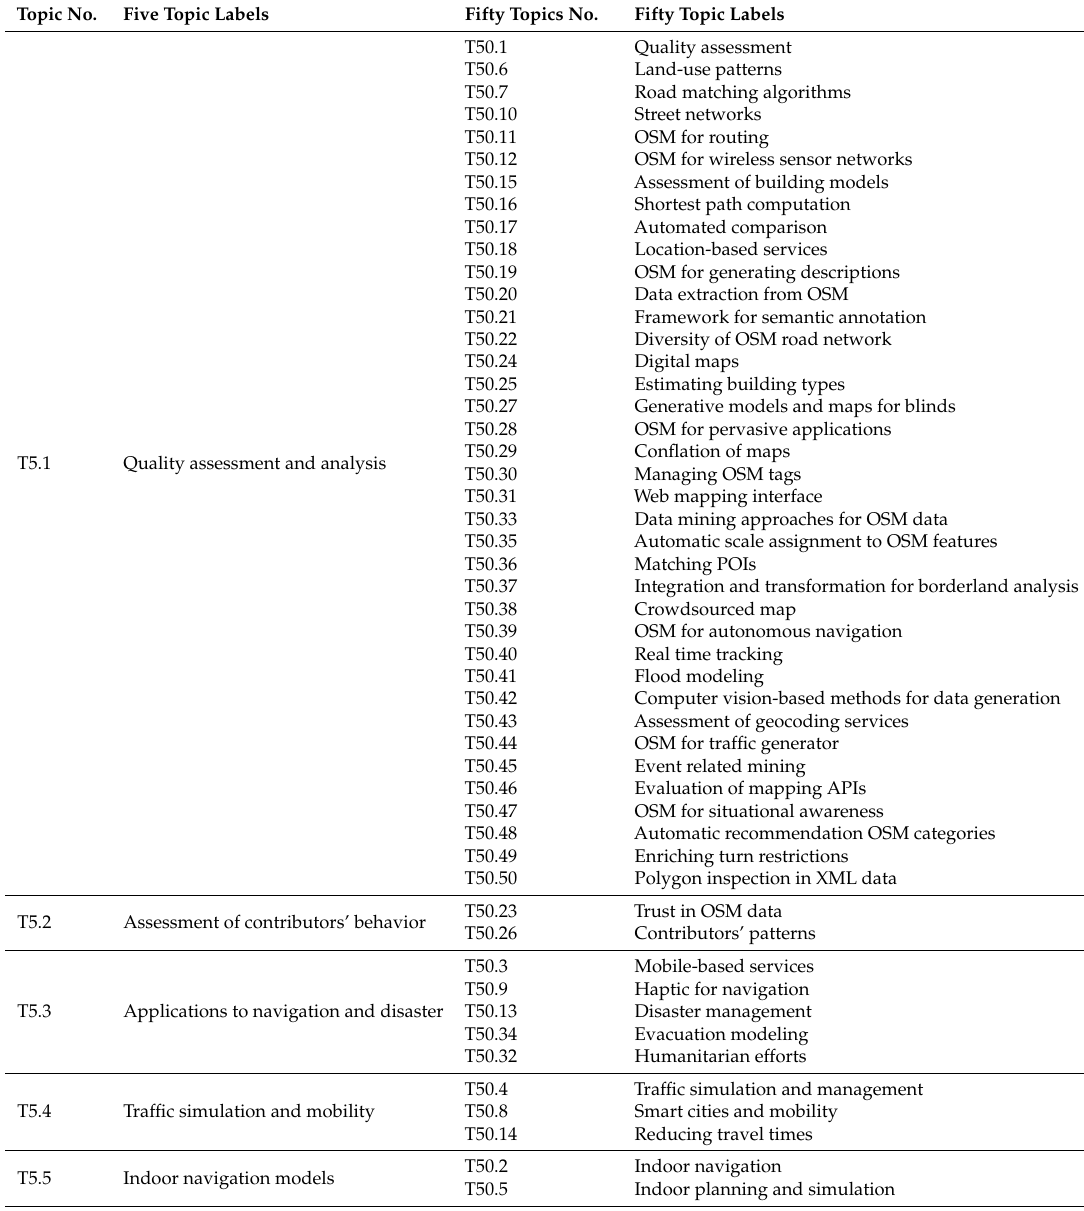
Table 9. Mapping of core research areas and